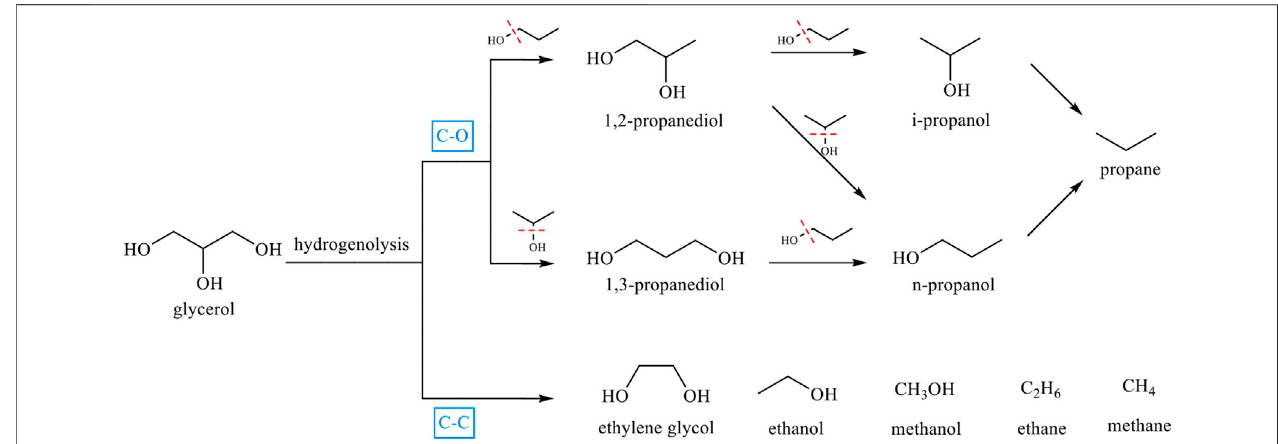
FIGURE 1 | Possible reactions and products from hydrogenolysis of glycerol over a heterogeneous catalyst.